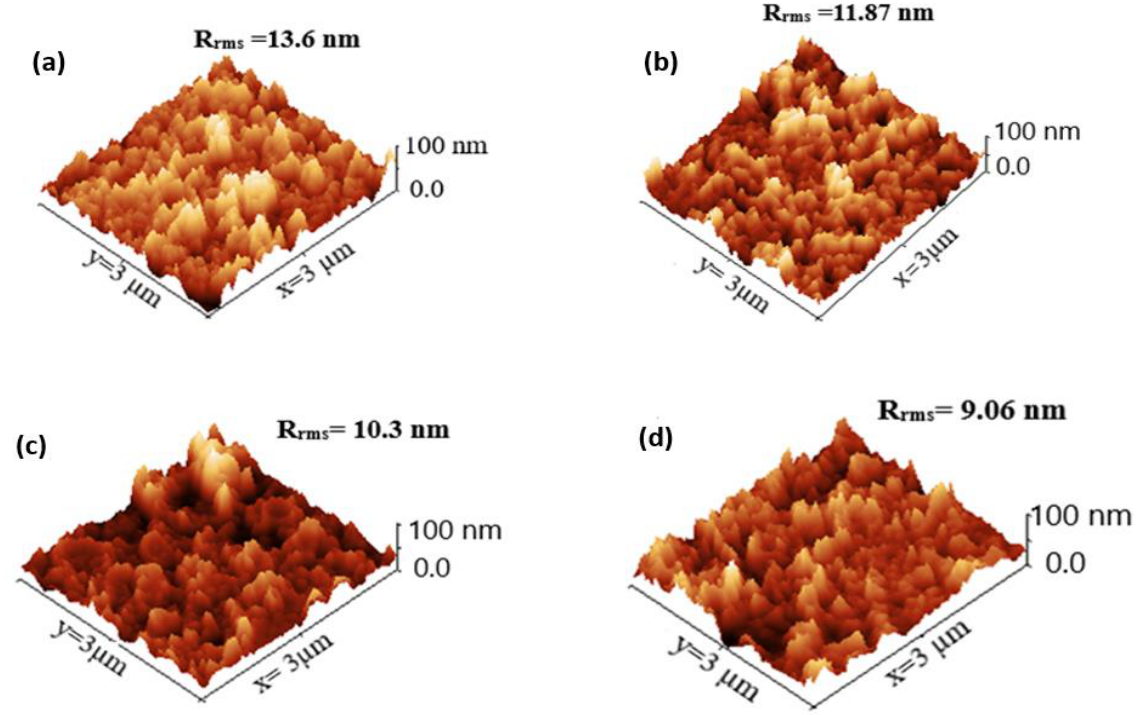
Figure 5. Three-dimensional AFM image of green synthesized NiO thin films on Cu substrate prepared at rotational speeds (RS) of ( a ) 700 RPM, ( b ) 900 RPM, ( c ) 1100 RPM, and ( d ) 1300 RPM.